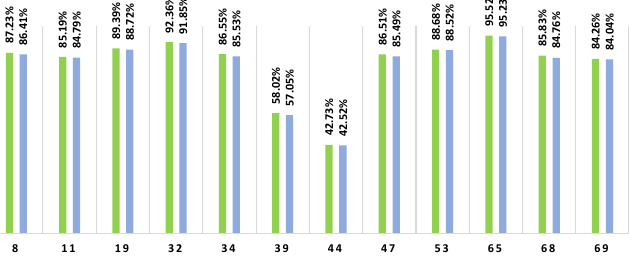
Figure 12. Indoor temperature according to the set-point 19 ÷ 21 ◦ C, percentage of time in different users: reference scenario in green, optimized scenario in light blue. Figure 11. Optimised scenario – Central heating system along the entire heating season [h]: supply (red) and return (blue) temperature [°C].